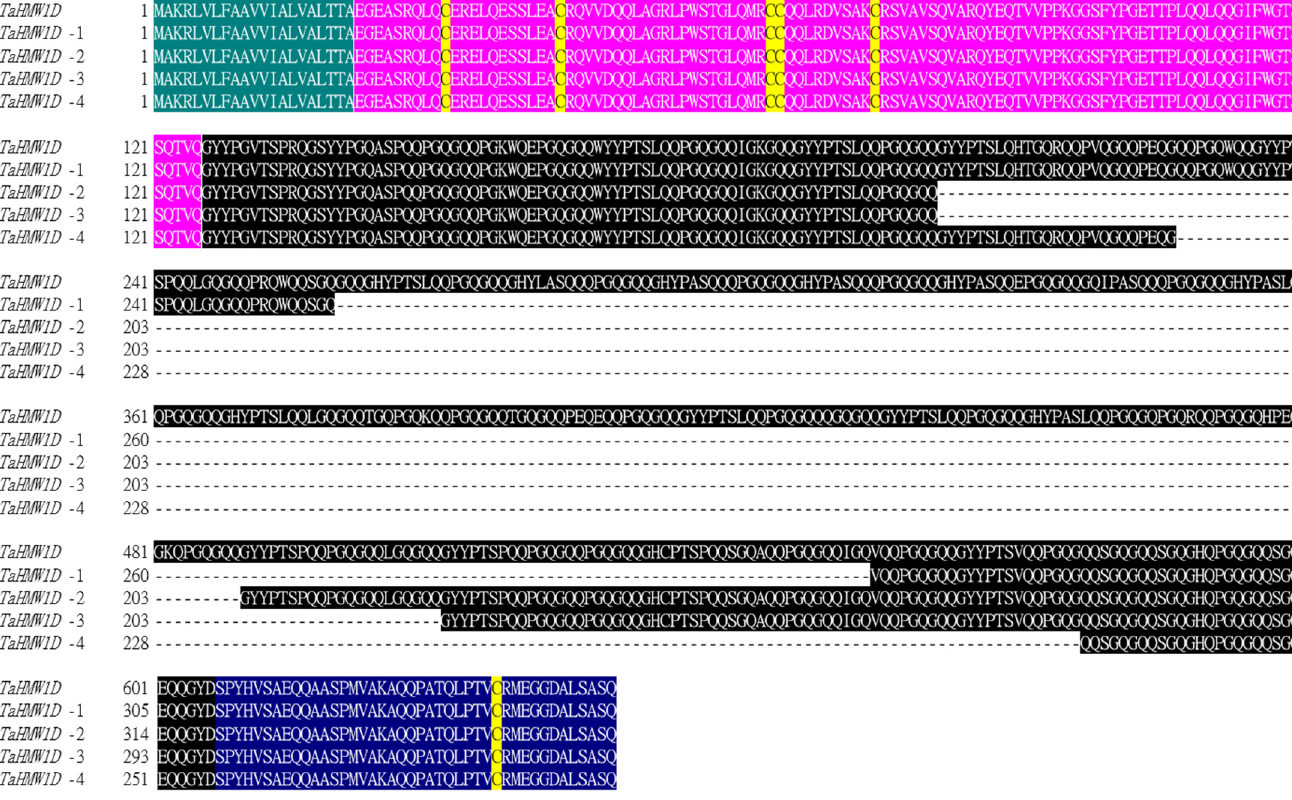
Figure 7. Protein sequence alignment of TaHMW1D and its transcript variants ( TaHMW1D -1, 2, 3, 4) in Keumgang. Green, signal peptide; pink, N-terminal peptide; black, repetitive region; blue, C-terminal peptide. The conserved cysteine is marked in yellow.